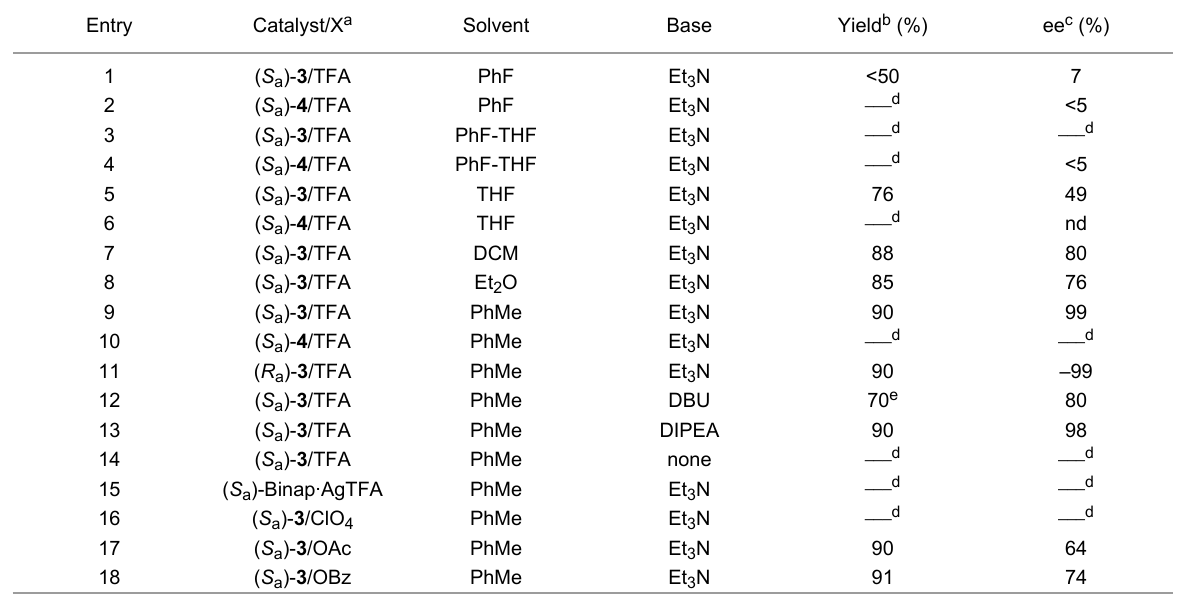
Table 1: Optimization of the 1,3-dipolar cycloaddition of 5a and NPM using chiral